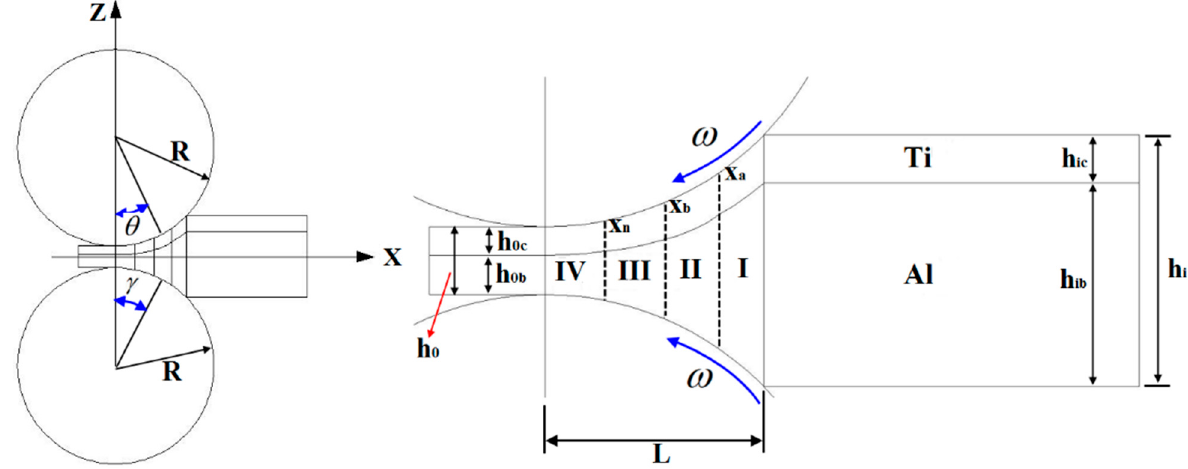
Figure 1. Schematic diagram of deformation zone of the Ti/Al composite sheet.